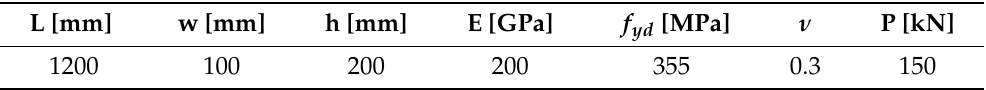
Figure 6. Illustration of benchmark problem. A cantilevering beam with a cross-section of 100 mm × 200 mm. The theoretical solution, using beam theory, is used as a reference for the analysis. Table 1. Input data for the cantilever